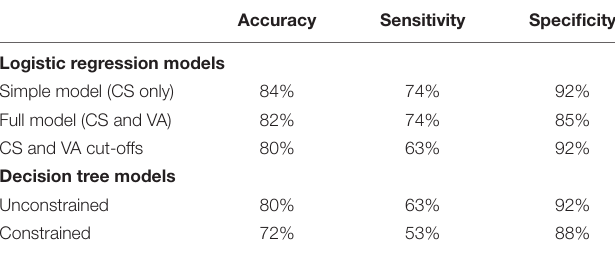
TABLE 3 | Comparison of the accuracy, sensitivity and specificity of the logistic regression and decision tree